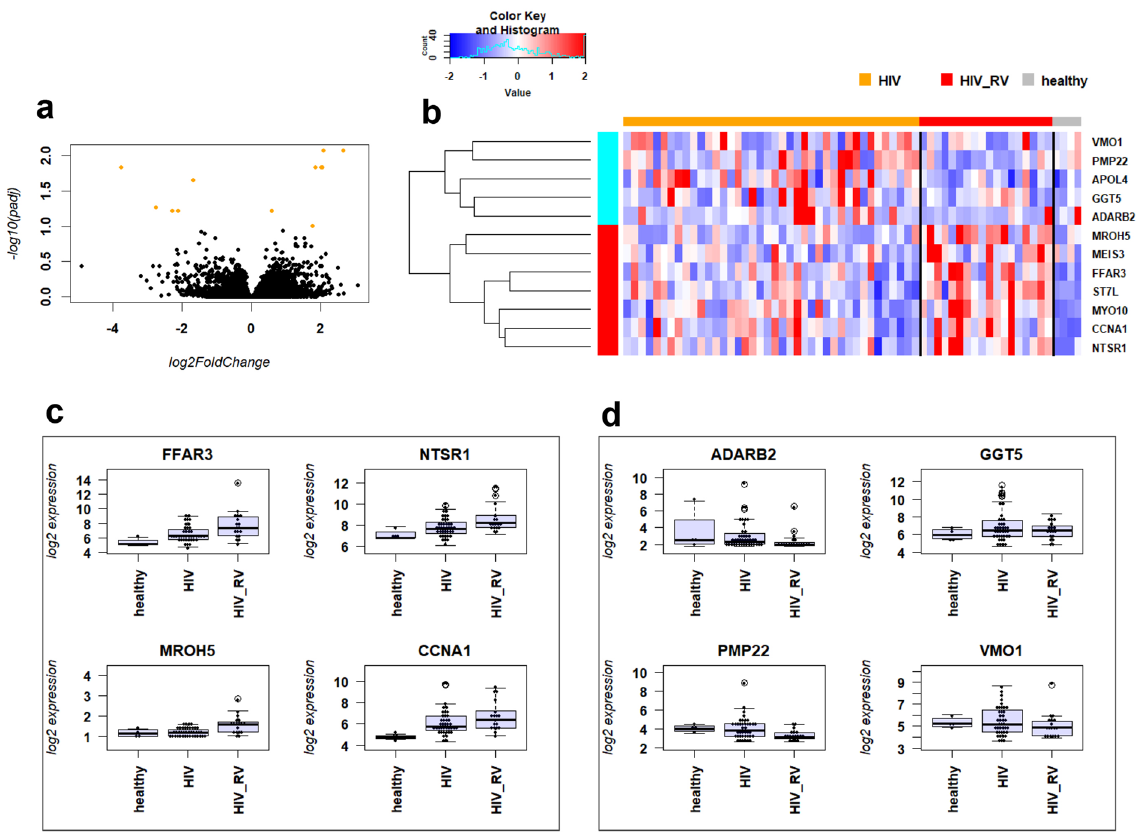
Figure 1. Visualization of DEGs in PWH cohort. ( a ) Volcano plot showing DEGs with thresholds of absolute fold change > 1.5 and a BH adjusted p value < 0.5 in yellow. ( b ) Heatmap of relative expression levels of DEGs identified between infected and non-infected PWH. Values were scaled by row. ( c ) Boxplot of individual gene expression levels as normalized log 2 expression values for top four up-regulated DEGs. ( d ) Boxplot of individual gene expression levels as normalized log 2 expression values for top four down-regulated DEGs. healthy: healthy controls; HIV: non-infected PWH; HIV_RV: PWH infected with respiratory virus. Gene name abbreviations: Free Fatty Acid Receptor 3 ( FFAR3 ), Neurotensin Receptor 1 ( NTSR1 ), Maestro Heat Like Repeat Family Member 5 ( MROH5 ), Cyclin A1 ( CCNA1 ), Adenosine Deaminase RNA Specific B2 ( ADARB2 ), Gamma- Glutamyltransferase 5 ( GGT5 ), Peripheral Myelin Protein 22 ( PMP22 ), Vitelline Membrane Outer Layer 1 Homolog ( VMO1